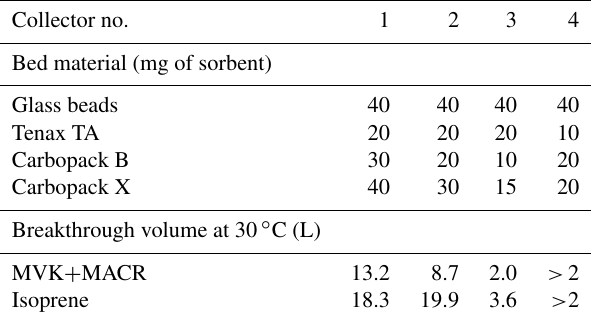
Table 1. Composition of different I/VOC collectors and correspond- ing breakthrough volumes for some of the most volatile target com- pounds. Collector 4 is a compromise between collectors 2 and 3 with reduced Tenax TA.